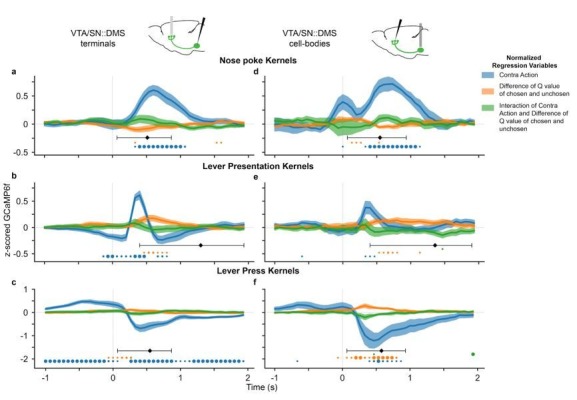
Kernels for each significant behavioral event for mixed effect model regression(A) Nose poke kernel output from linear regression model using GCaMP6f from VTA/SN::DMS terminals. Each line represents a normalized regression variable: action (blue; 0 for ipsilateral, 1 for contralateral), difference in Q values for chosen direction and unchosen direction (orange), and the interaction between the two (green). Colored fringes represent 1 standard error from activity averaged across recording sites (n = 12). Black diamond represents the average latency for lever presentation from nose poke with the error bars showing the spread of 80% of the latency values. (B) Lever presentation kernels, with the black diamond representing the average latency from lever press to lever presentation. (C) Lever press kernels, with the black diamond representing the average latency from CS+ or CS- to lever press. (D-F) Same as (A-E), except with signals from VTA/SN::DMS cell bodies averaged across recording sites (n = 7) instead of terminals.